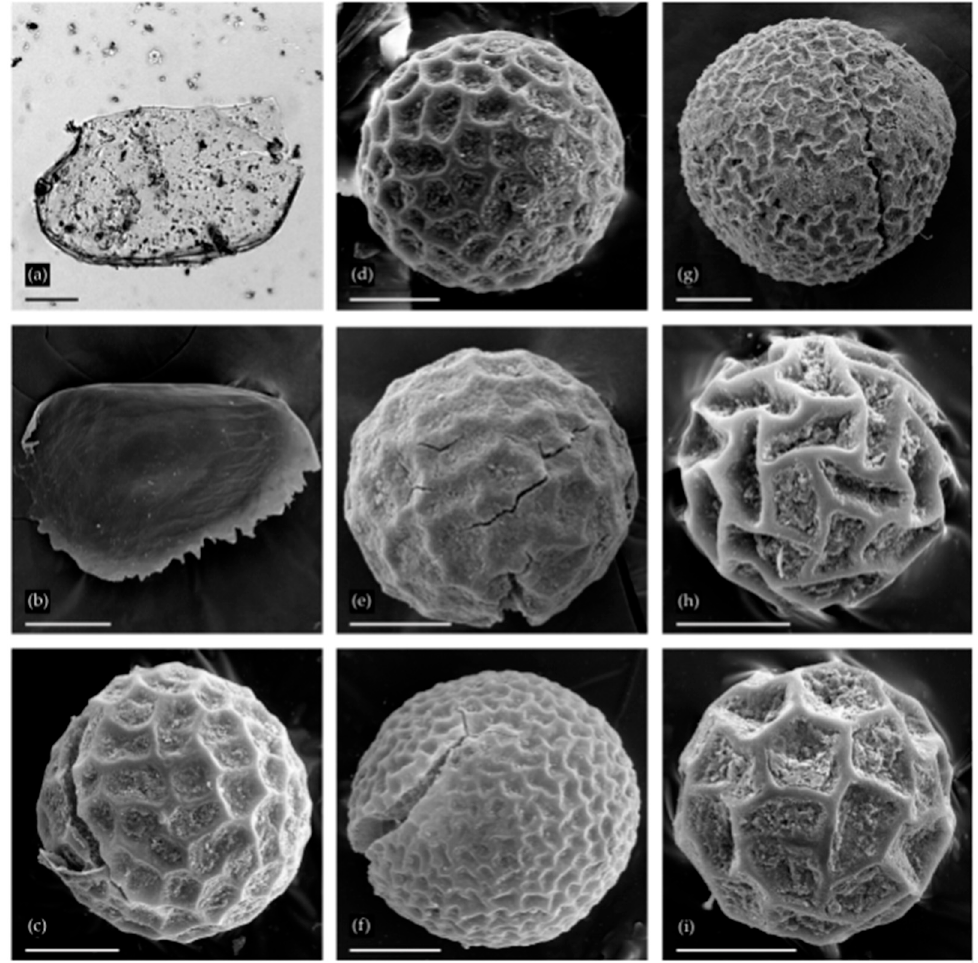
Figure 4. Remains of Cladocera ( a ) – ( b ) and resting eggs of Anostraca ( c ) – ( i ) from two localities: ( a ) Chydorus cf. sphaericus from Urtuy, valve; ( b ) Alona s. lat. from Urtuy, ephippium; ( c ) – ( g )